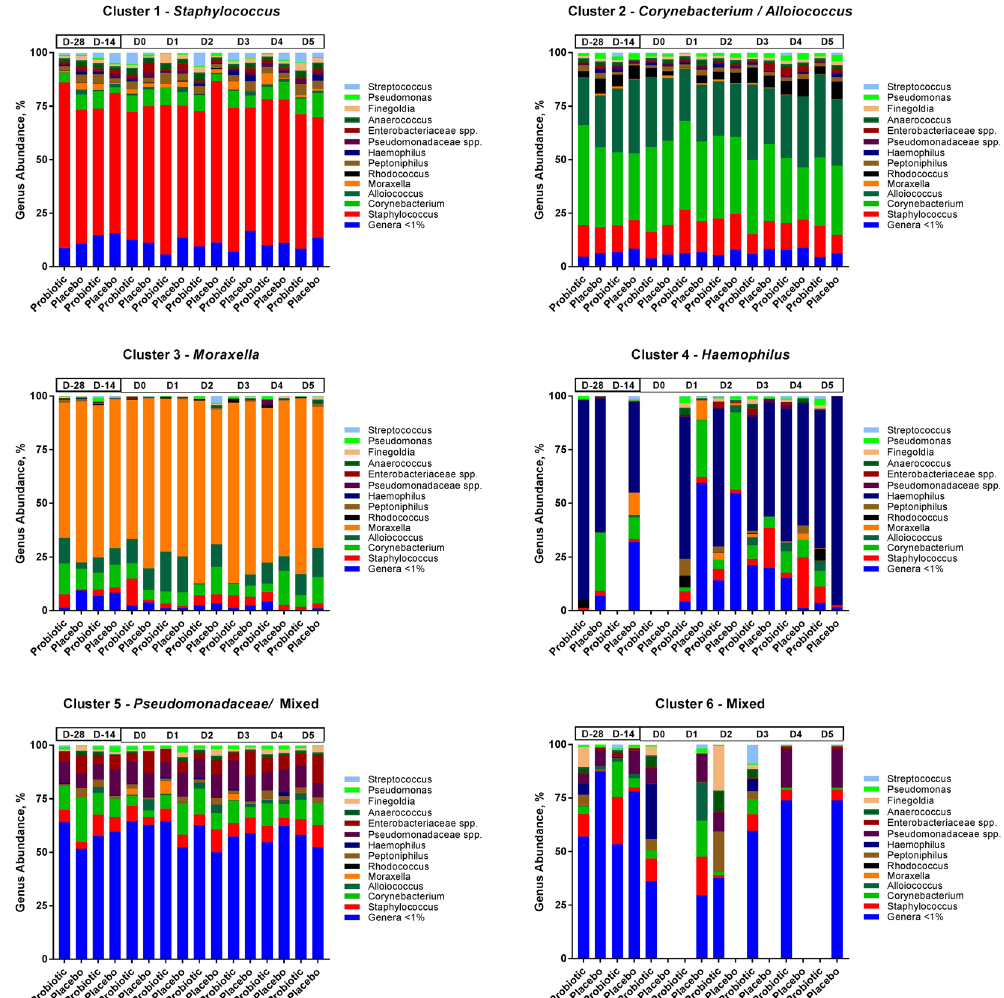
Figure 3. Relative abundance (%) of bacterial genera in the nasal microbiotas of six clusters in the two study groups over study time. The number of samples for each time and treatment point is shown in Supplementary Table 1.